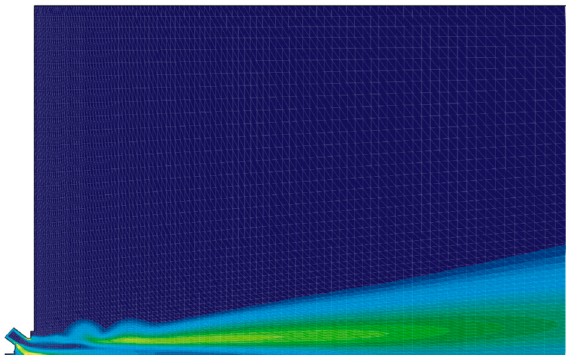
Figure 7. Turbulent kinetic energy of the flow with non-swirling atomizing air.